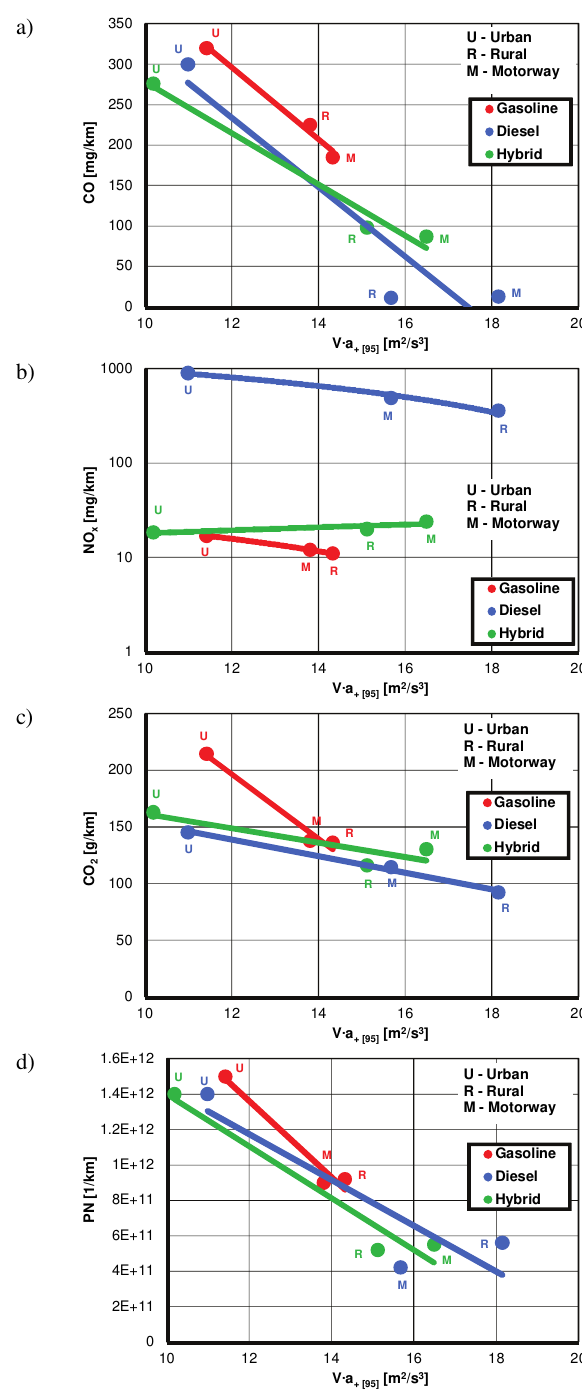
Fig. 16. Correlations between exhaust emissions and 95 th percentile of the velocity and positive acceleration product in particular stages of the test: a) carbon monoxide, b) nitrogen oxides, c) carbon dioxide, d) particle